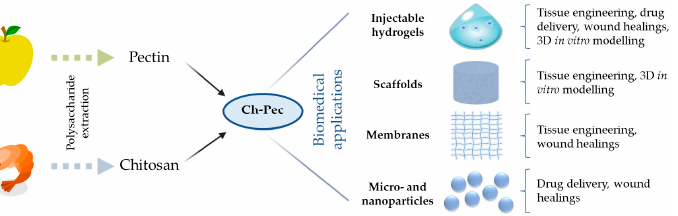
Figure 1. Scheme illustrating chitosan and pectin source of extraction and their combined used for biomedical